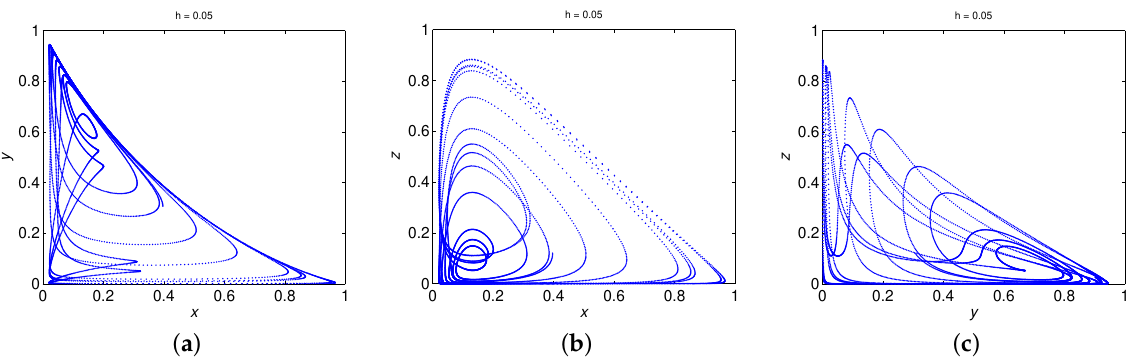
Figure 6. Projection of the attractor to system (1) onto the planes by each variable x , y and z . ( a ) Host cells: X = x ; ( b ) immune effector cells: X = y ; ( c ) tumor cells: X = z